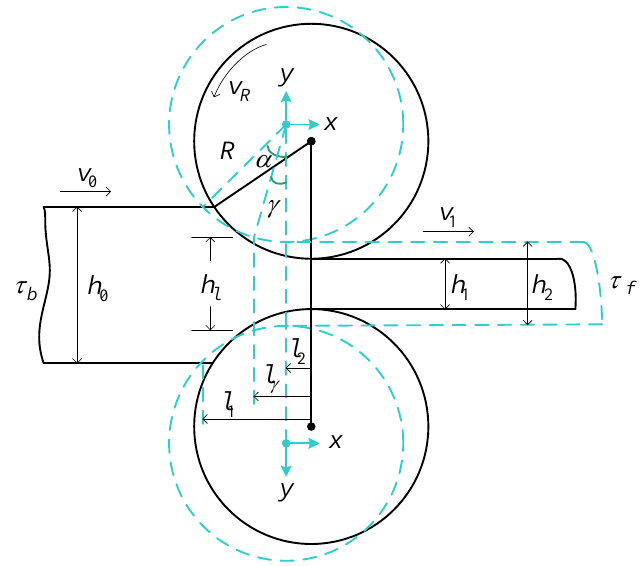
Figure 8. Dynamic deformation process of the workpiece. In Figure 8, the solid line indicates the roll position in the steady state, and the dotted line indicates the roll position in the vibration state. R is the roll radius, v R is the roll speed, and α is the bite angle. v 0 and v 1 are the entry and exit velocities of the workpiece in the steady state, respectively, h 0 and h 1 are the entry and exit thicknesses of the workpiece in the steady state, respectively, h 2 is the exit thickness of the workpiece in the vibration state, τ b and τ f are the entry and exit tensions, respectively. l 1 and l 2 are the distances from the solid line roller center line to the vibration state at the entrance and exit, respectively. Assuming that the shape of the roll gap is a parabola [27], when vibration occurs, the section thickness of the workpiece at any position l of the roll gap is as follows: ℎ 𝑙 = ℎ 1 + (𝑙 − 𝑥) 2 𝑅